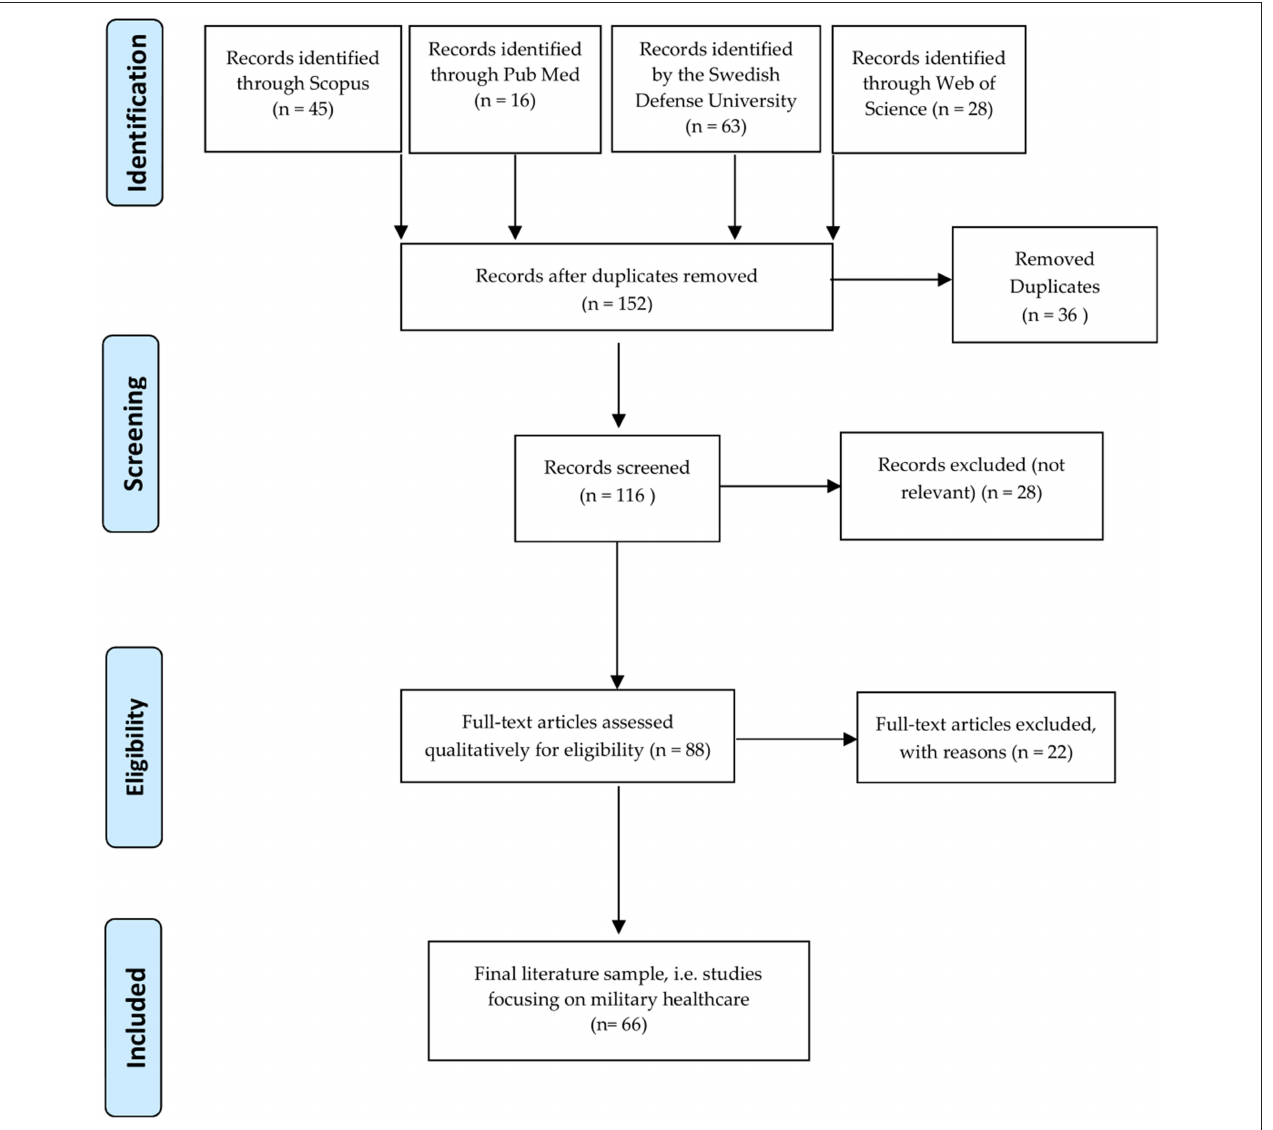
FIGURE 1 | Flow diagram of included records for this